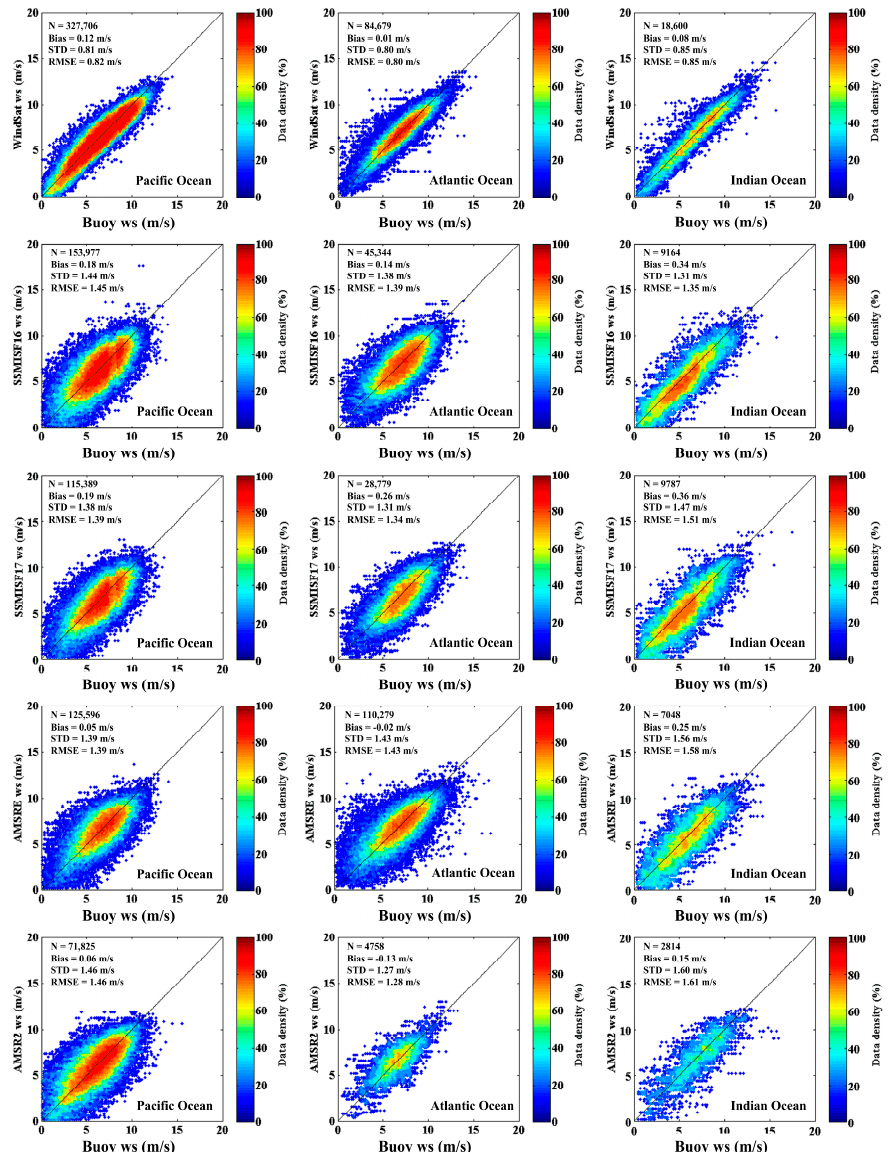
Figure 2. Scatterplots of collocated satellite (WindSat, SSMIS F16, SSMIS F17, AMSR-E, and AMSR2) wind speeds and buoy measurements in different ocean regions: the tropical Pacific Ocean, the tropical Atlantic Ocean, and the tropical Indian Ocean.